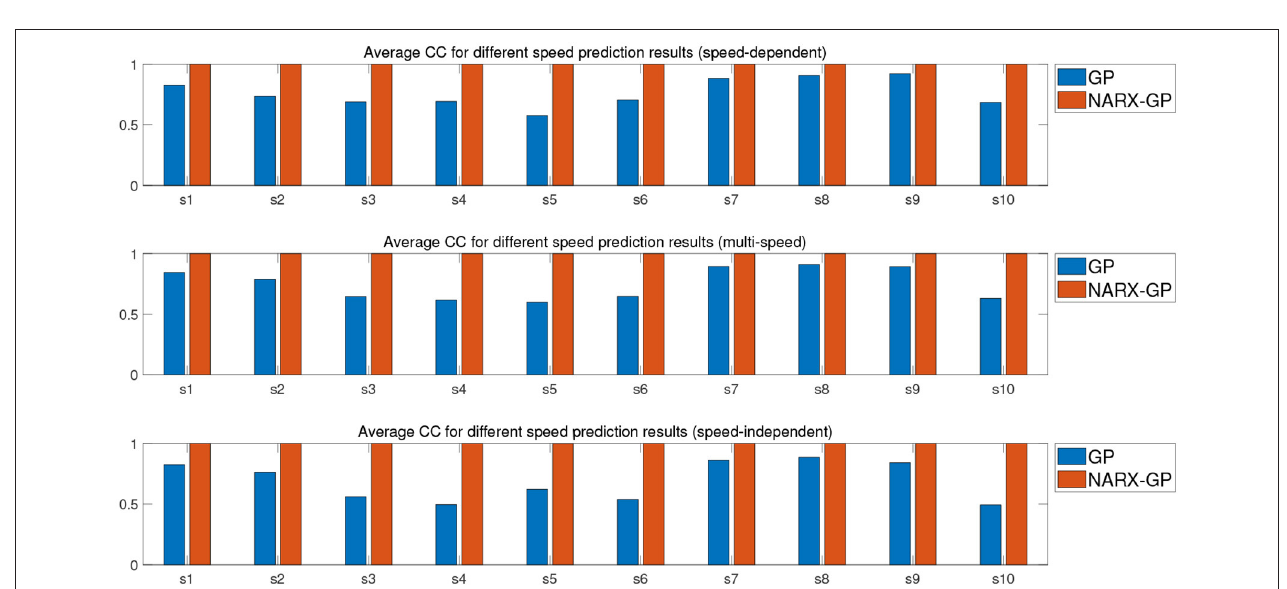
FIGURE 10 | Average CC for prediction of joint angle under different speed.